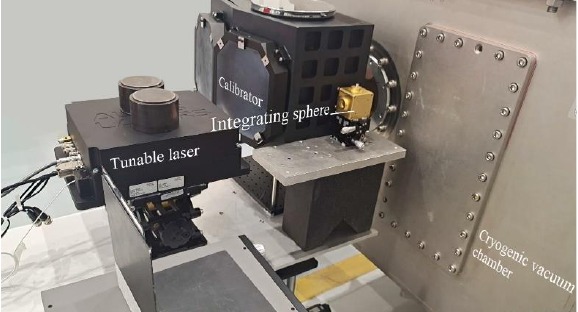
Figure 20. Layout of the spectral calibration system of the LWIR imaging spectrometer.